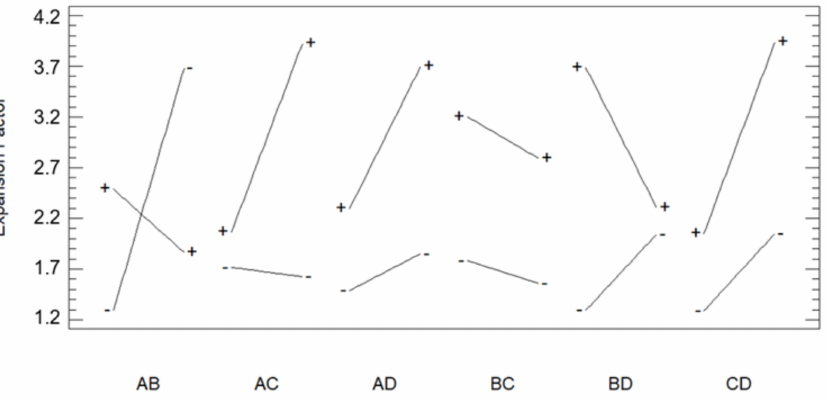
Figure 5. Effect from the interactions between the considered variables on the expansion factor of the foamed polymer samples (A: Pressure; B: Temperature; C: LA/GA ratio; D: Depressurization